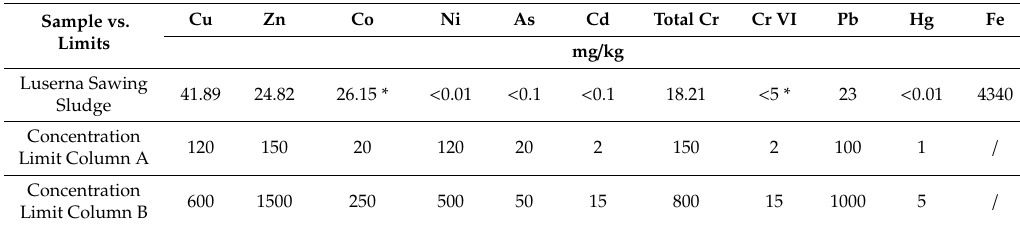
Table 1. Results obtained from chemical analysis on Luserna sawing sludge tested (according to Lgs.D. 152 / 2006 Annex 5, title V, part IV and Art. 8 of the M.D. 05 / 02 / 1998). Last two rows indicate the limit of concentration of green area (column A) and commercial area (column B). * the results over the limits of column A.